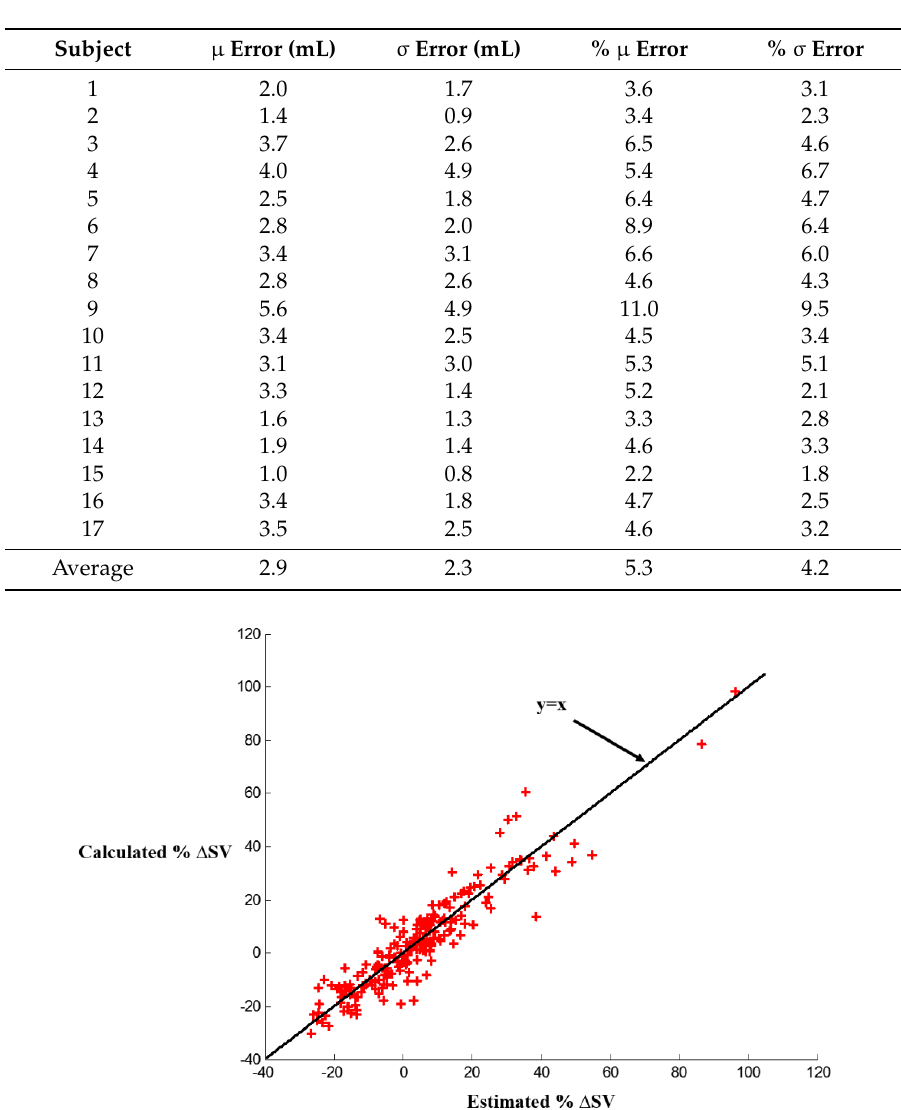
Table 1. Per subject errors in ∆SV estimation.